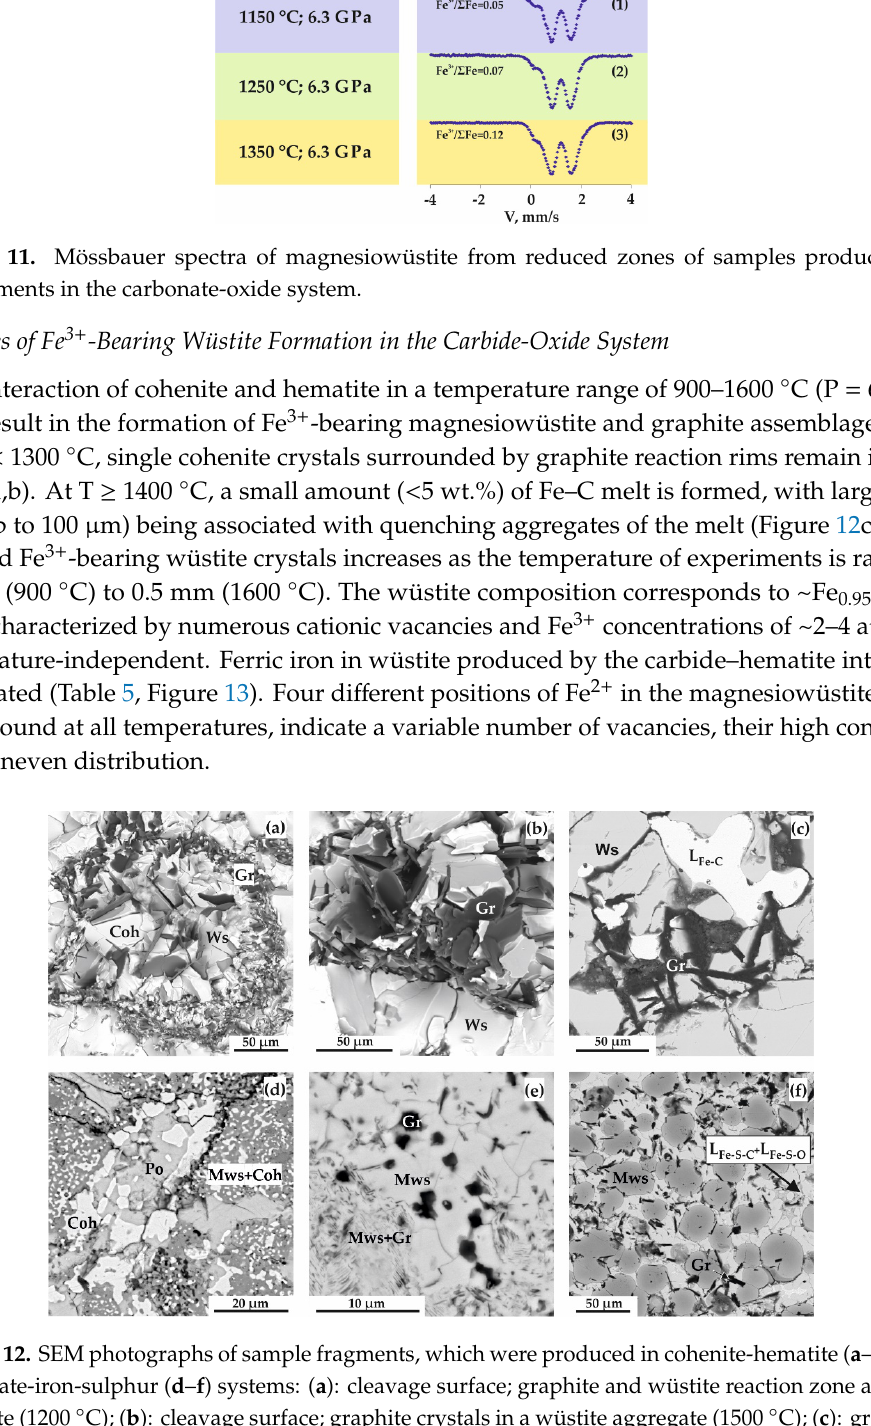
Figure 12. SEM photographs of sample fragments, which were produced in cohenite-hematite ( a – c ) and carbonate-iron-sulphur ( d – f ) systems: ( a ): cleavage surface; graphite and wüstite reaction zone around cohenite (1200 ° С ); ( b ): cleavage surface; graphite crystals in a wüstite aggregate (1500 ° С );